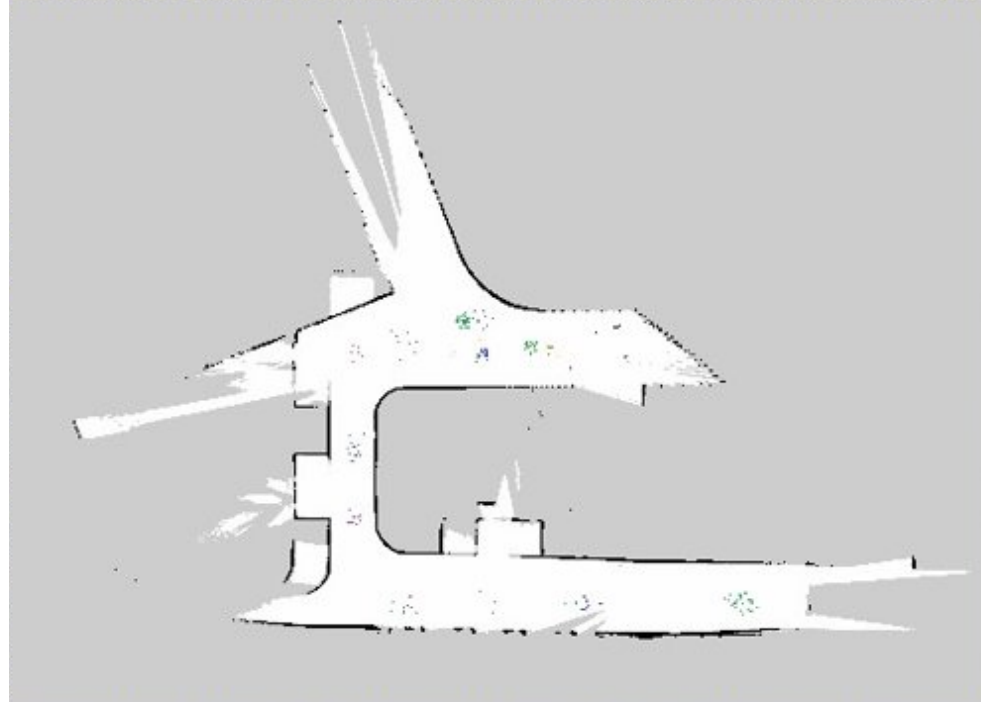
Figure 11. Mosquito population mapping. Table 5. Statistical results of mosquito glue